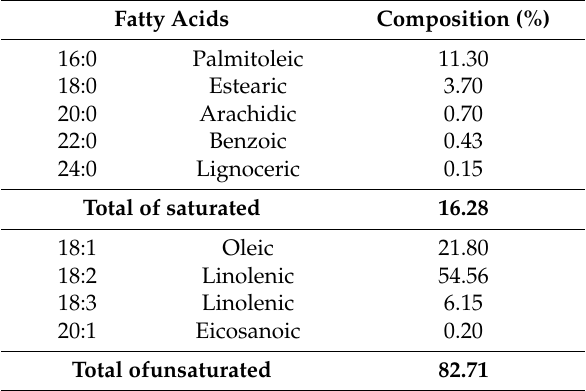
Table 2. Fatty acids profile determined by gas